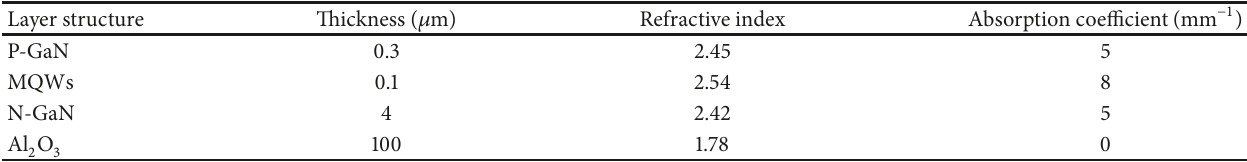
Figure 1: (a) The structure of blue LED; (b) the model of blue COB. Table 1: The material parameters of each layer of blue